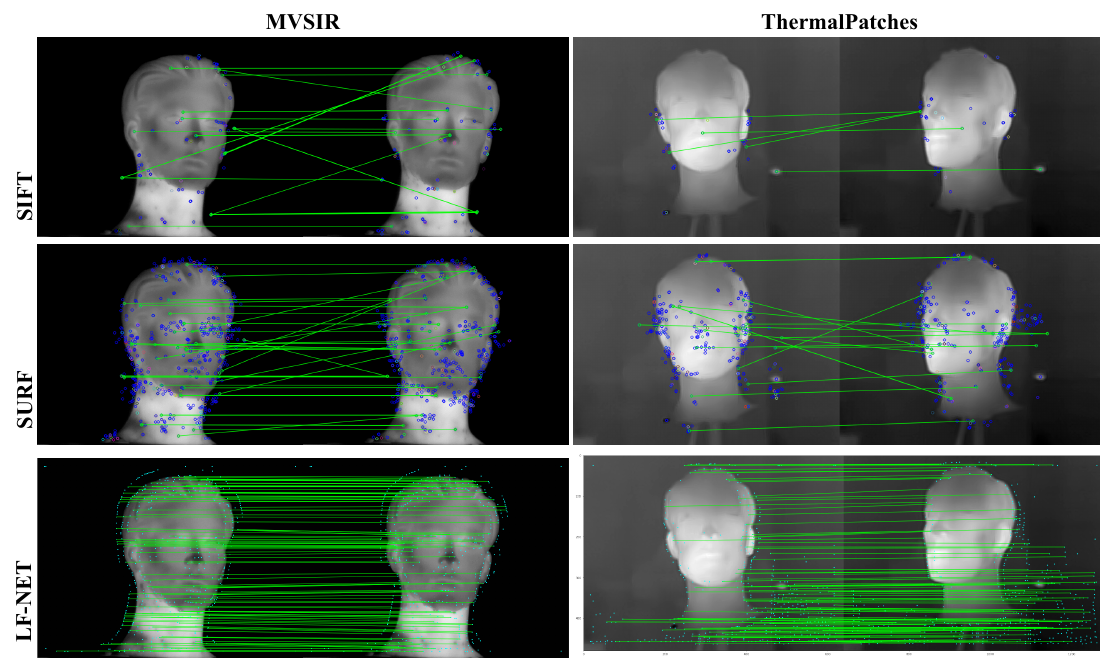
Figure 6. Evaluation of three feature point matching algorithms on two